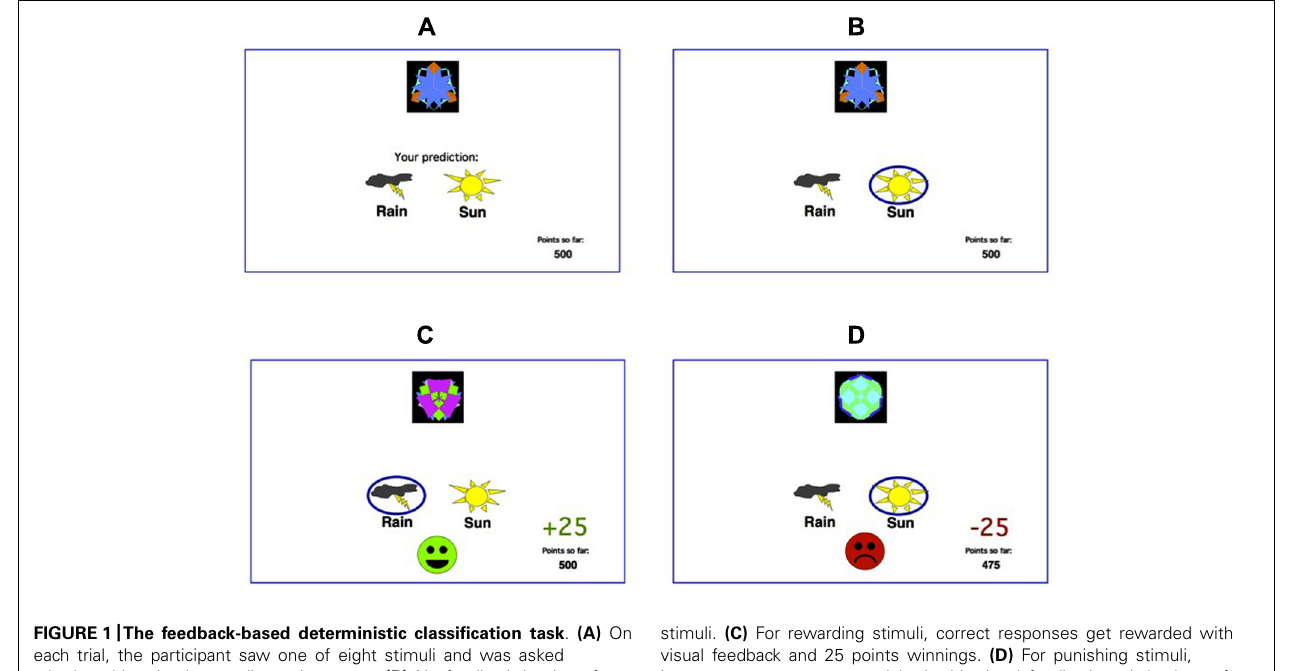
FIGURE 1 |The feedback-based deterministic classification task . (A) On each trial, the participant saw one of eight stimuli and was asked whether this stimulus predicts rain or sun. (B) No feedback is given for incorrect answers in rewarding stimuli or correct answers in punishing